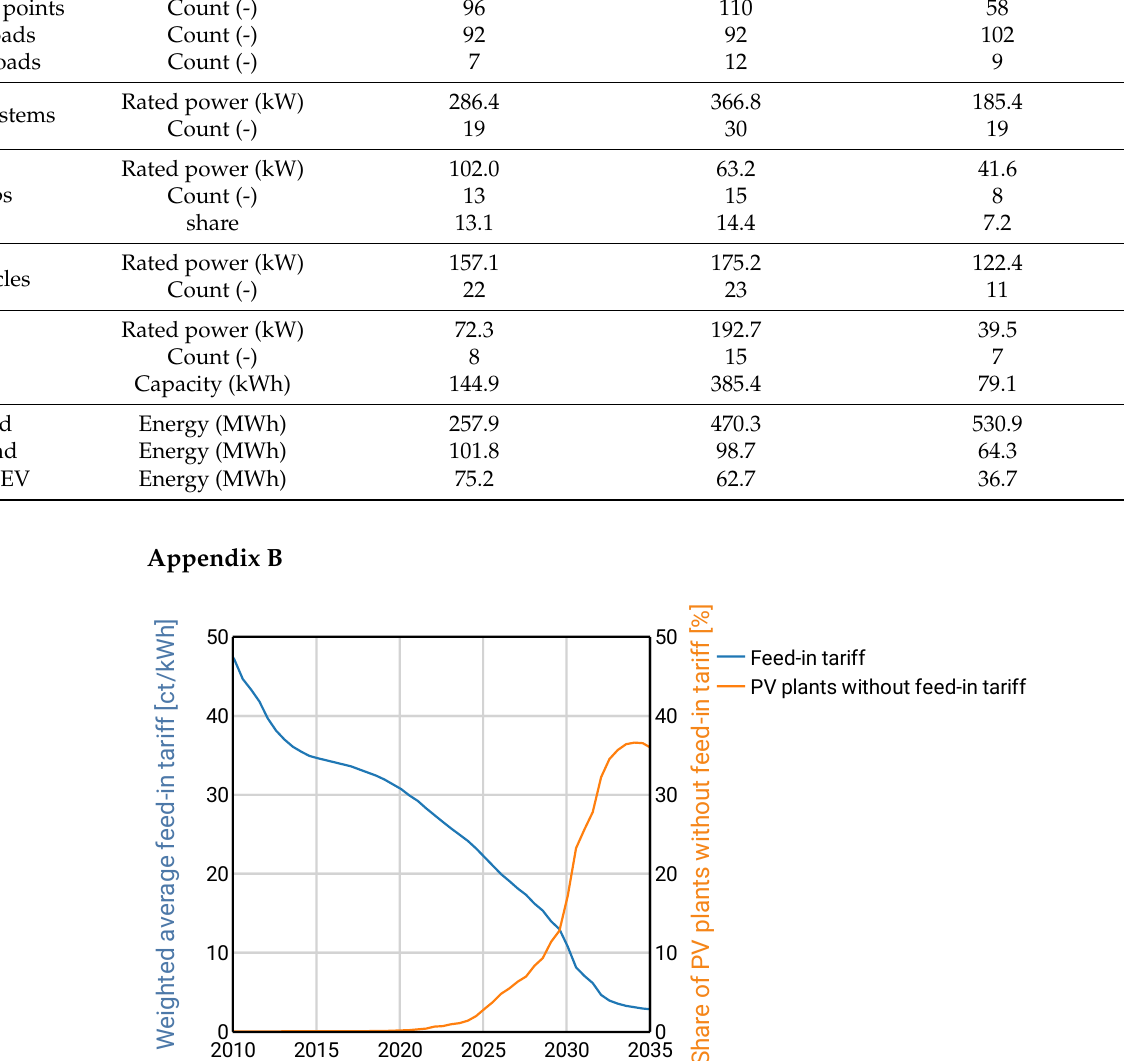
Figure A2. Heatmap of the electric demand (positive values) and feed-in (negative values) for the flat participant fee scenario, the scenario year 2035 and the rural grid.